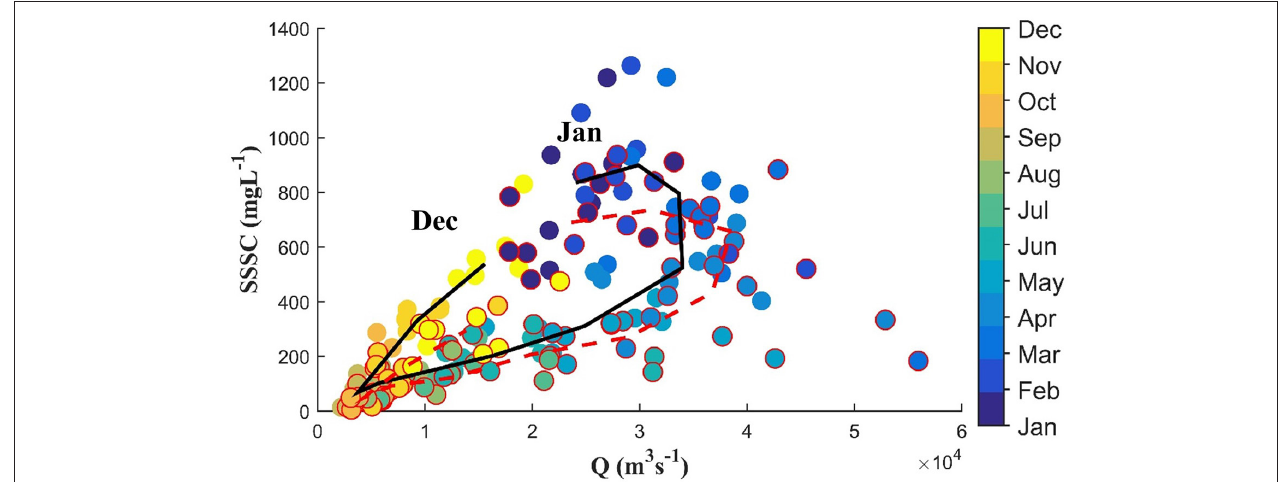
FIGURE 3 | Water discharge (Q)–Surface suspended sediment concentrations (SSSC) relationship at Porto Velho in the Upper Madeira basin. Black (red dash) lines represent the 2003–2009 (2010–2017) period. Dots bordered in red indicate SSSC data of the 2010–2017 period.